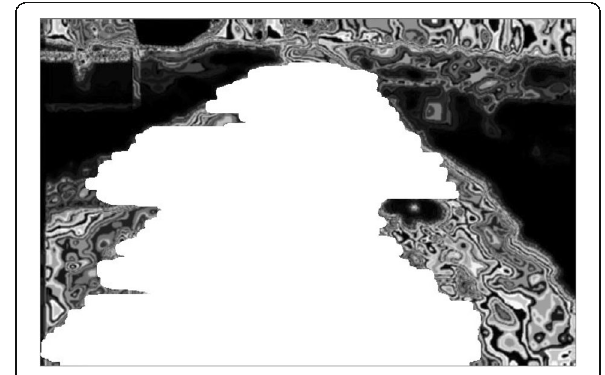
Fig. 14 Road region marking diagram Fig. 15 Road region based on backprojection probability map